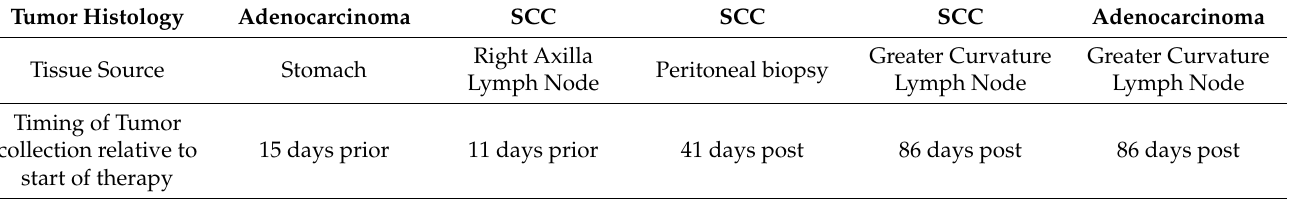
Table 1. Actionable and additional alterations of interest detected by Oncomap TM ExTra